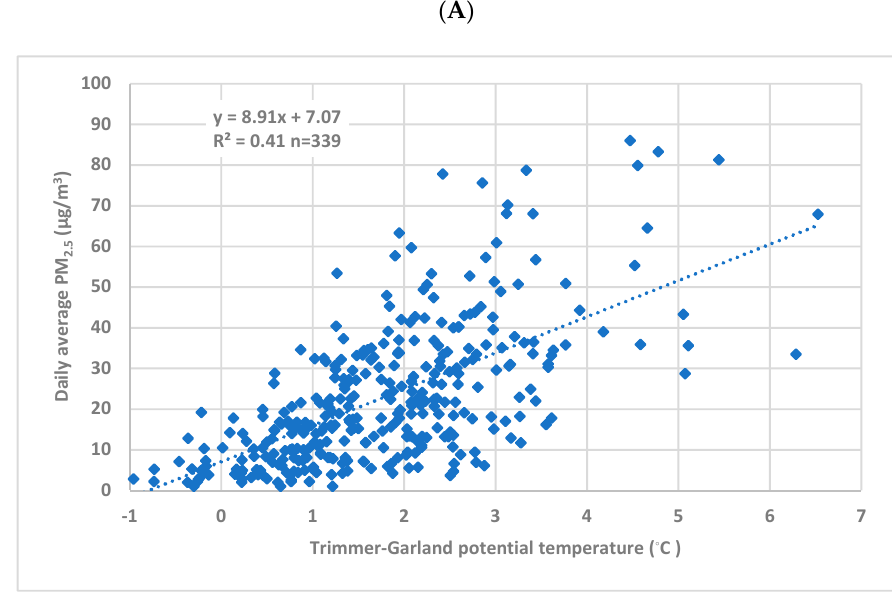
between the Garland and Fancher Creek ( A ) and Trimmer ( B ) sites.